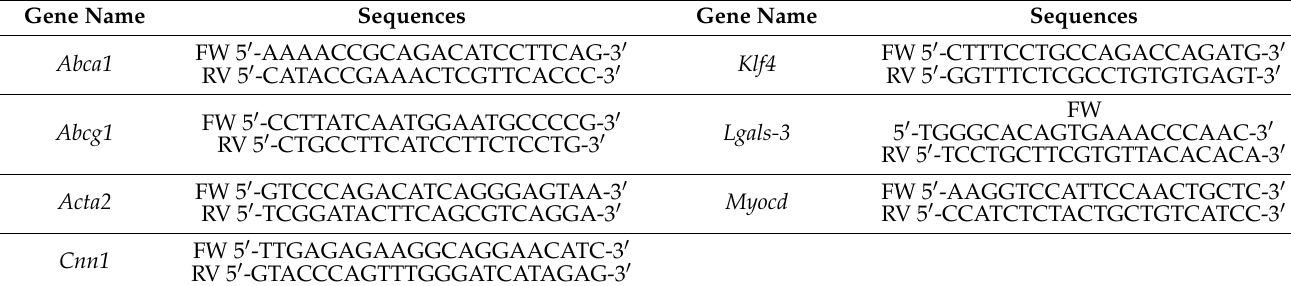
Table 2. Sequences of mouse